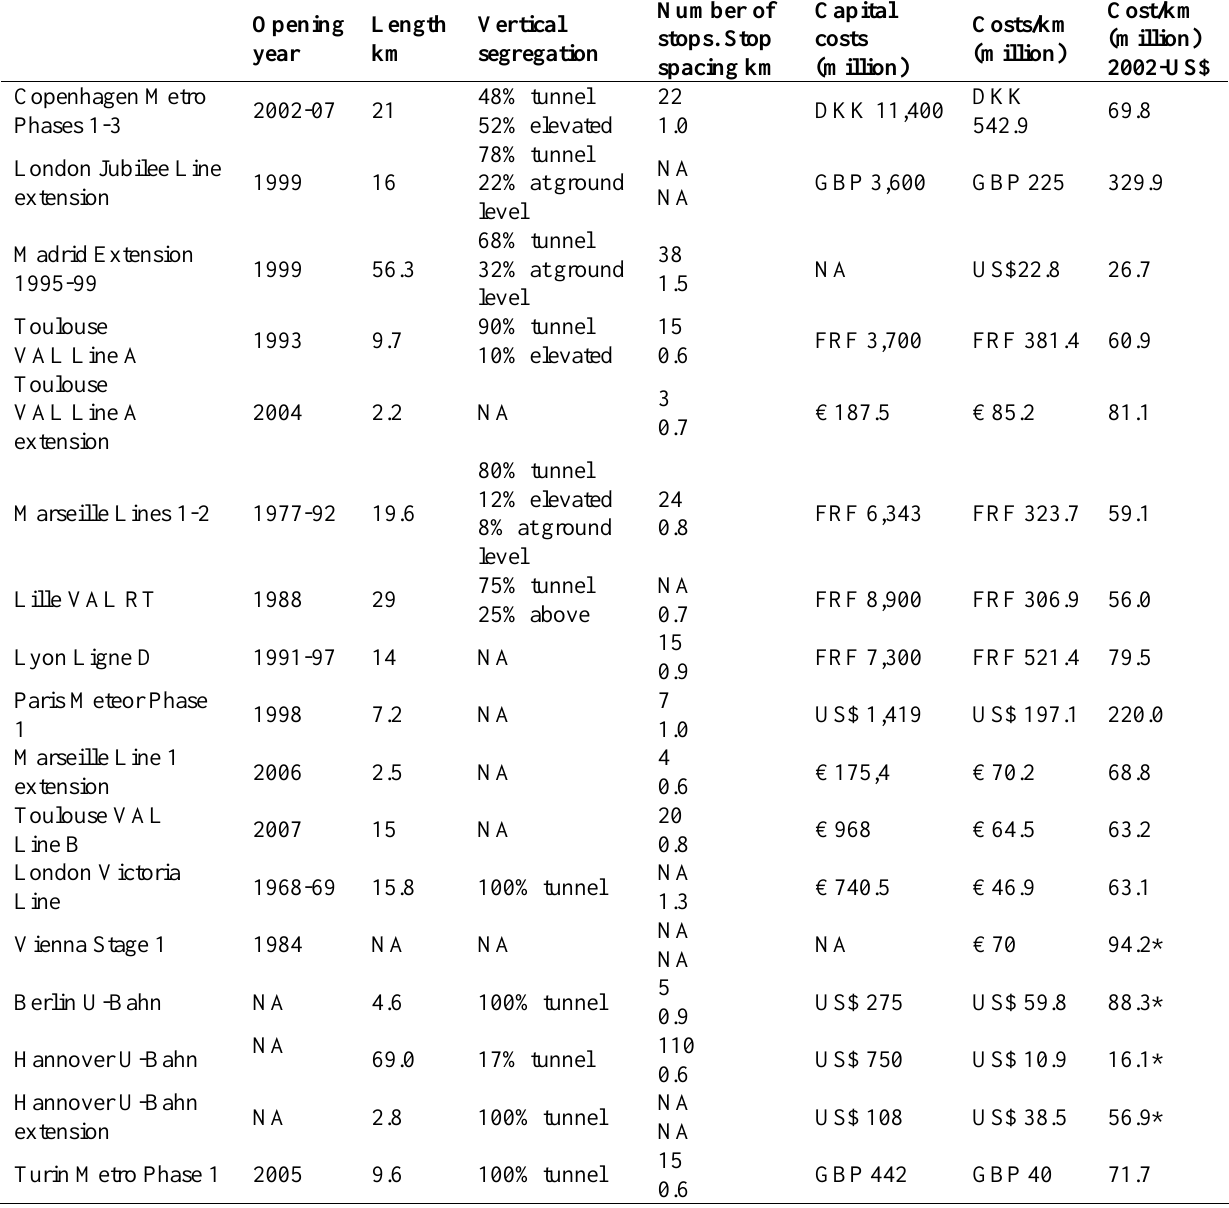
Table 1. Capital costs per route-kilometre for selected urban rail